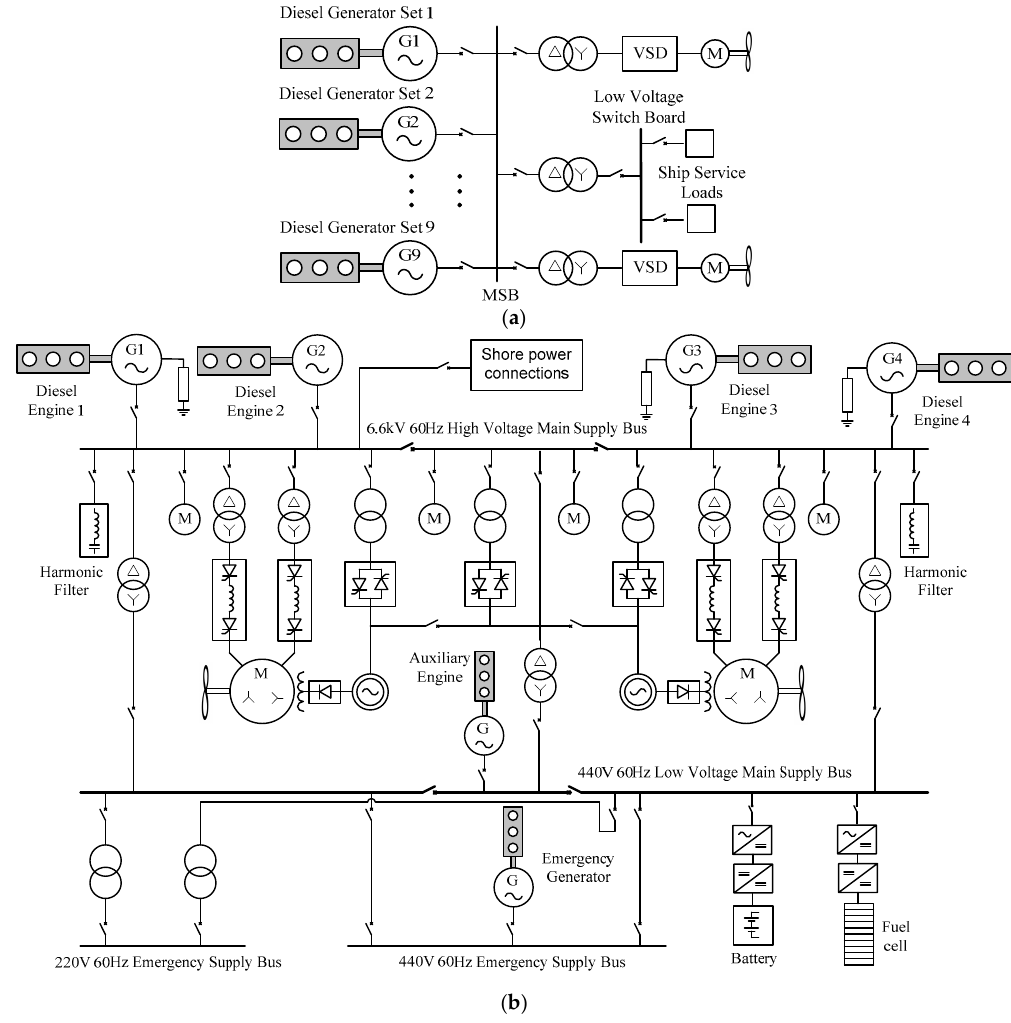
Figure 1. ( a ) Power system architecture of the Queen Elizabeth II cruise ship; ( b ) Example of a radial AC distribution system. (M: motor, MSB: main switchboard, VSD: variable speed drice) .